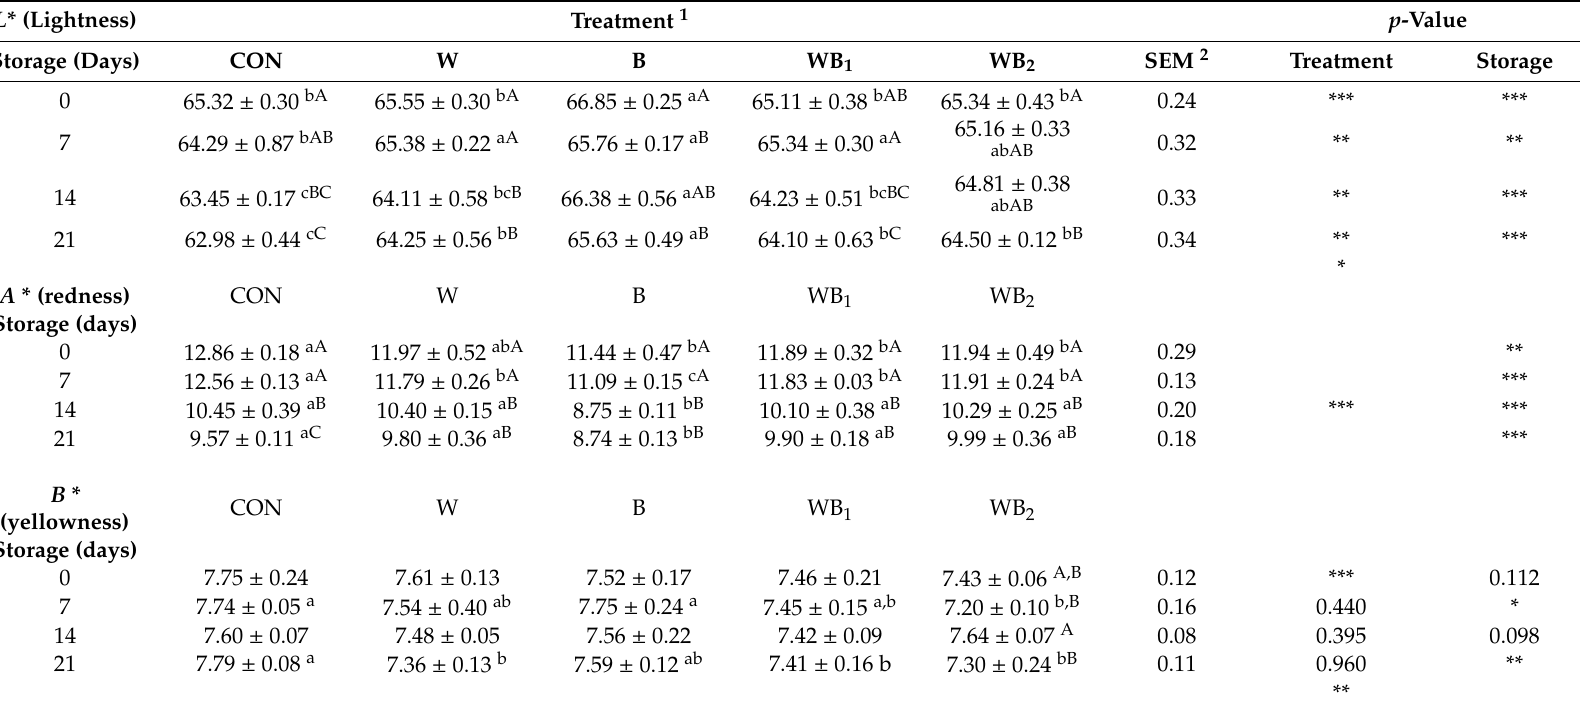
Table 3. E ff ects of Boswellia serrata and whey powders on the color of pork patties during